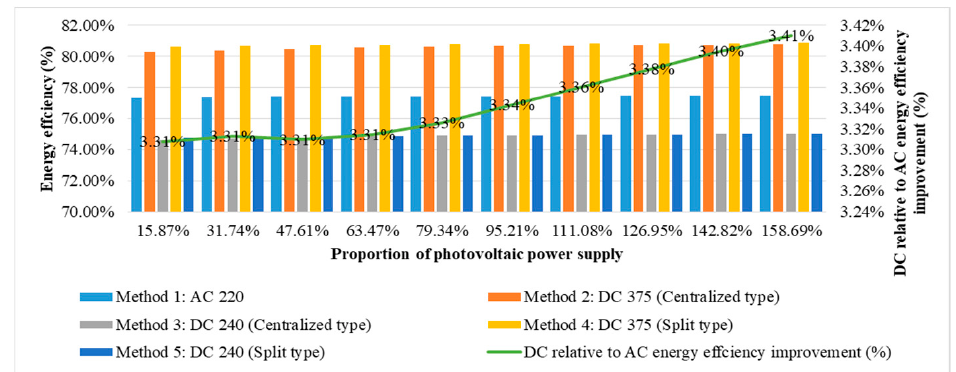
Figure 17. The relationship between the proportion of energy storage capacity and the improvement of DC–AC energy efficiency.